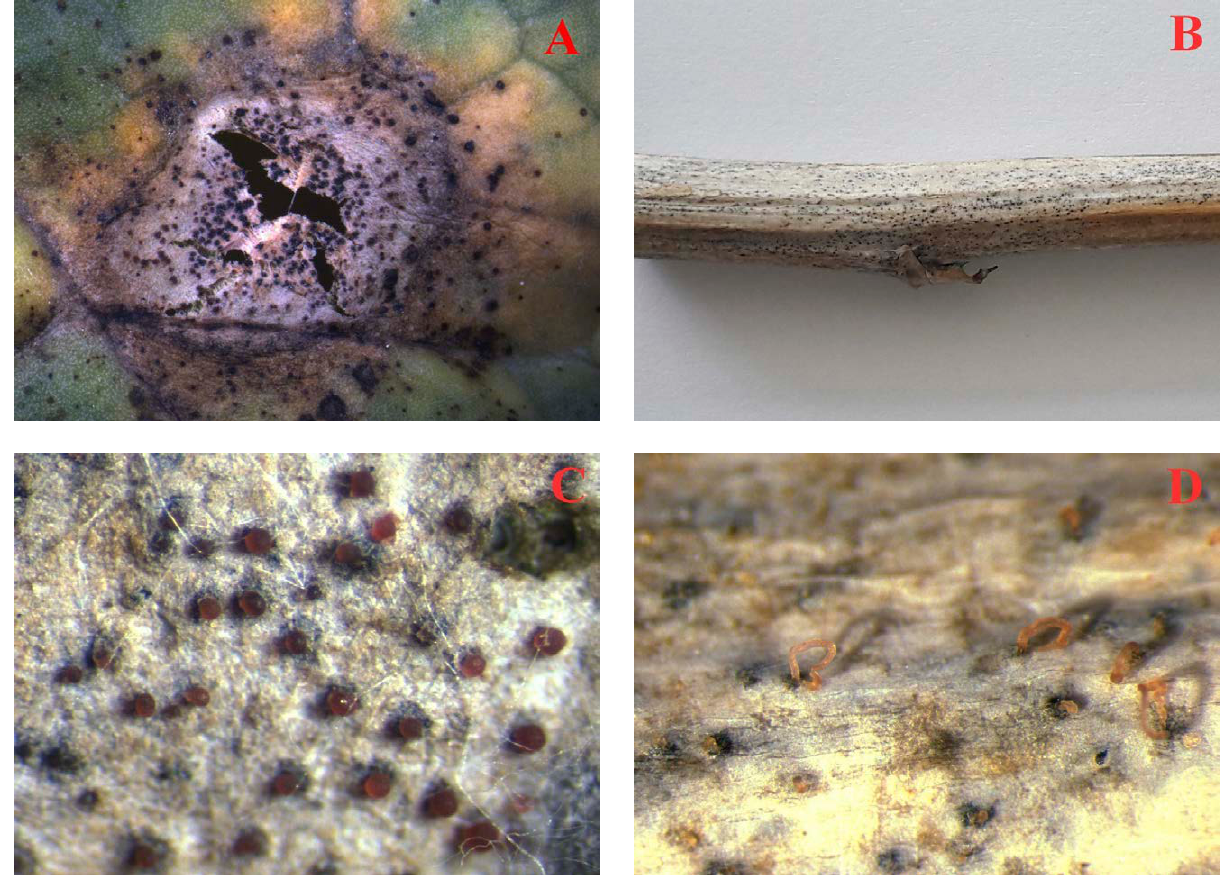
Figure 1. Leaf lesion on oilseed rape hybrid ‘Marc KWS’ (A), and stem necrosis with black pycnidia on hybrid ‘Alvaro KWS’ (B). Pycnidia on a leaf of hybrid ‘Gordon KWS’ (C) and a stem of hybrid ‘Umberto KWS’